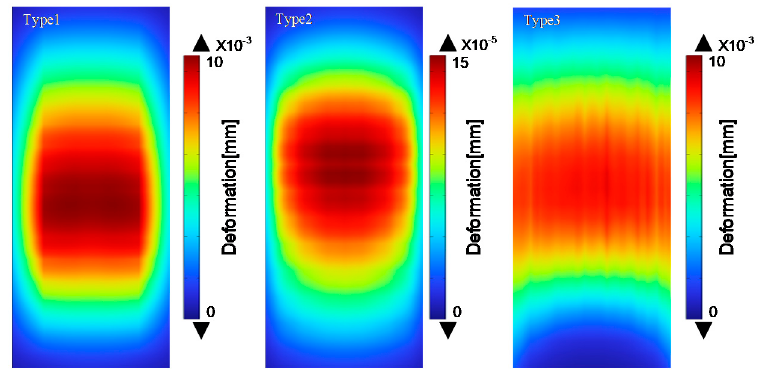
Figure 6. Deformation of three different rails.